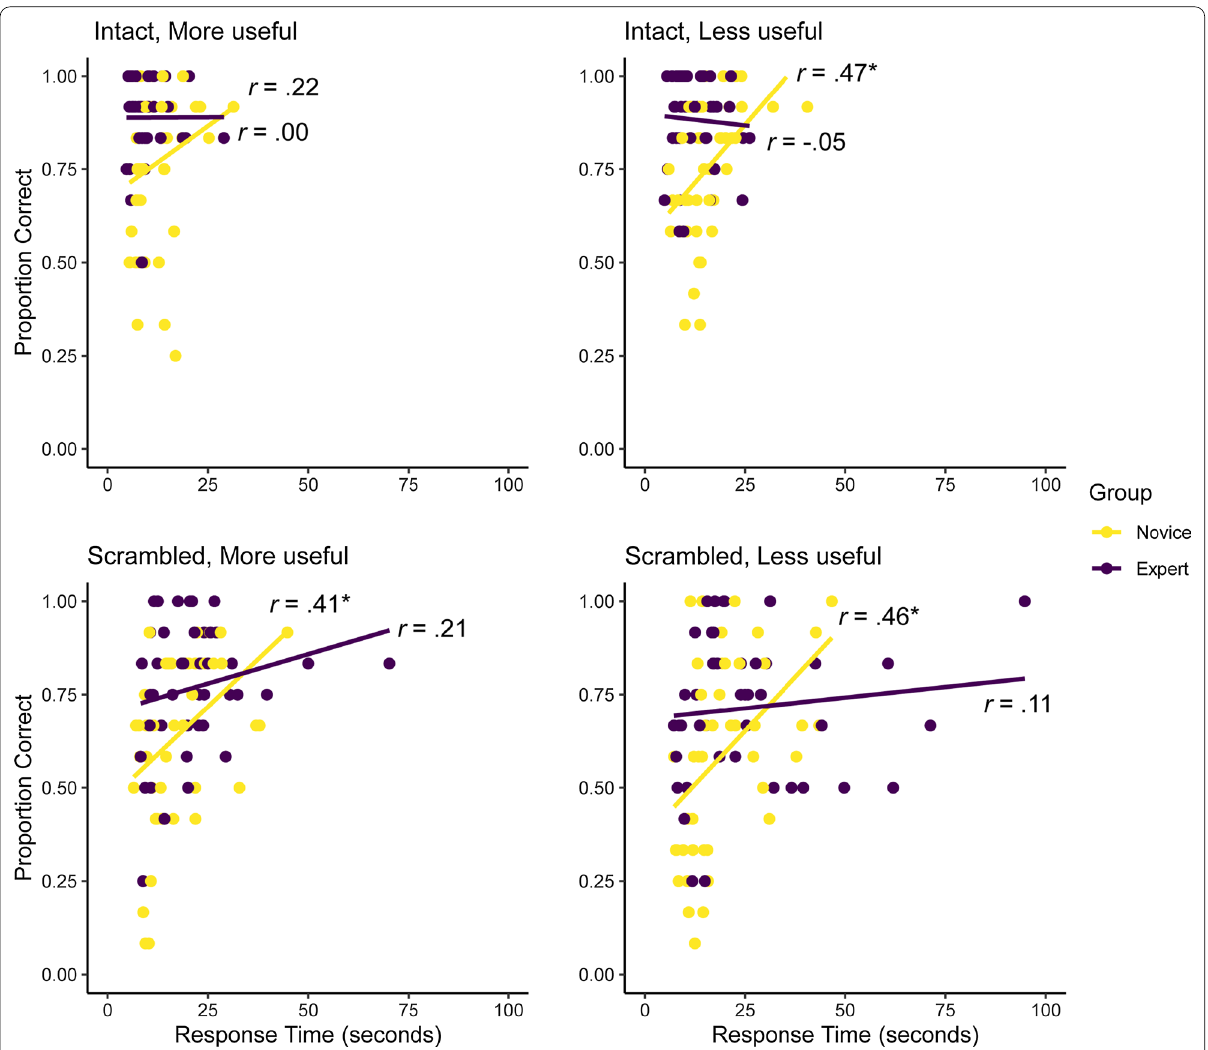
Fig. 5 The correlations between speed and accuracy for each group across the four conditions in the Spot-the-Difference task. An asterisk (*) signifies a significant correlation ( p <